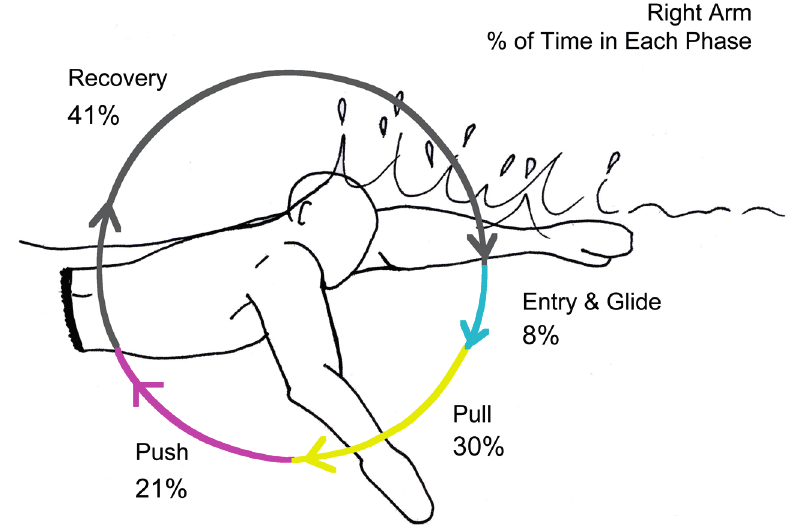
Figure 16. Example output of the system for